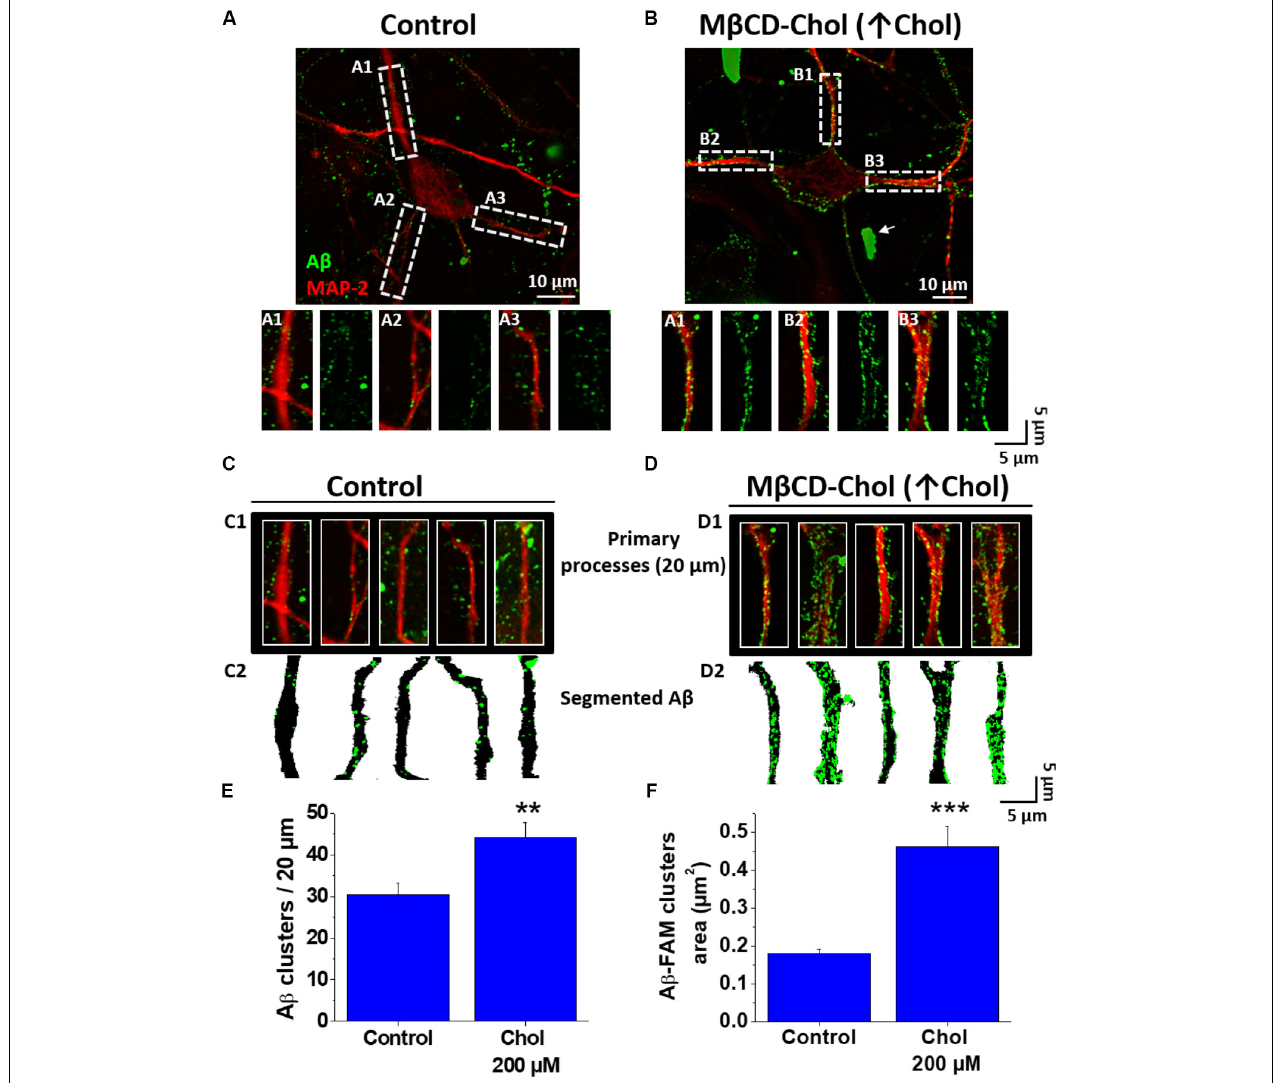
FIGURE 3 | Increased cholesterol promotes association of A β to neurons. (A,B) Confocal microscopy images of hippocampal neurons exhibiting fluorescence for MAP-2 and demonstrating the distribution of A β 42 -FAM aggregates (green) on the cell membrane after treatment with M β CD-Cholesterol complex (200 µ M) for 20 min. (A1–A3,B1–B3) ROIs of representative neurites show the overall distribution of A β (1 µ M, after 1 h) on neuronal processes in more detail. (C,D) Representative traces of primary processes shown in (A,B) , respectively. (E,F) Quantification of A β clusters (number and area) in the first 20 µ m of hippocampal neuron primary processes showing that both parameters were increased after treatment with M β CD-Cholesterol complex (200 µ M) for 20 min. The bars represent the mean ± SEM. Asterisks denote: ∗∗ p < 0.005 and ∗∗∗ p <